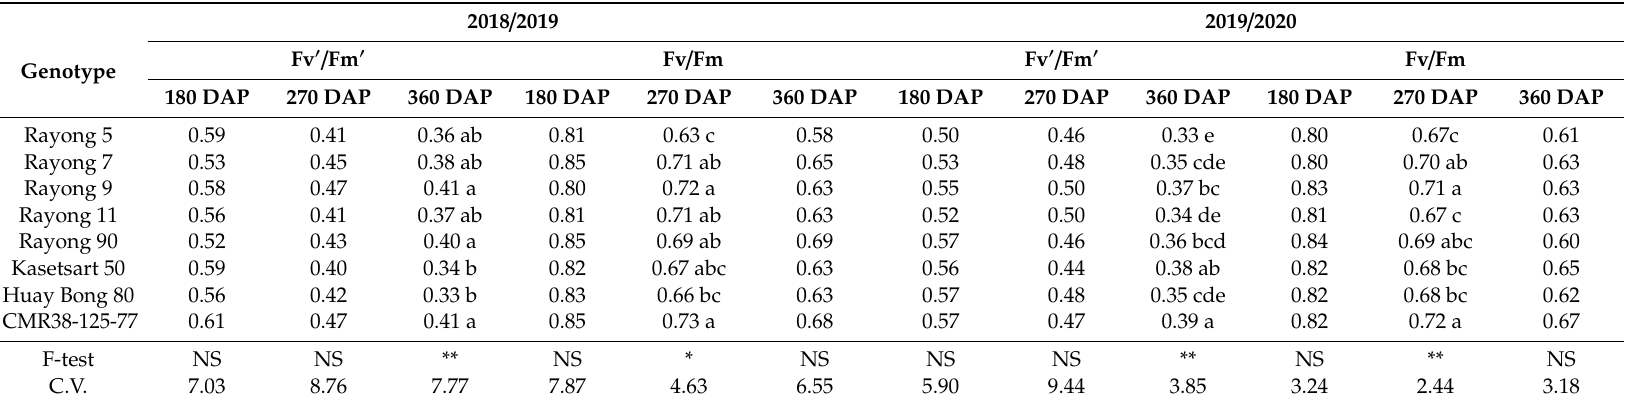
Table 5. E ff ective quantum yield of PSII photochemistry (Fv (cid:48) / Fm (cid:48) ) and maximum photochemical quantum yield of PSII (Fv / Fm) at di ff erent days after planting (DAP) for eight cassava genotypes grown in 2018 / 2019 and 2019 / 2020.